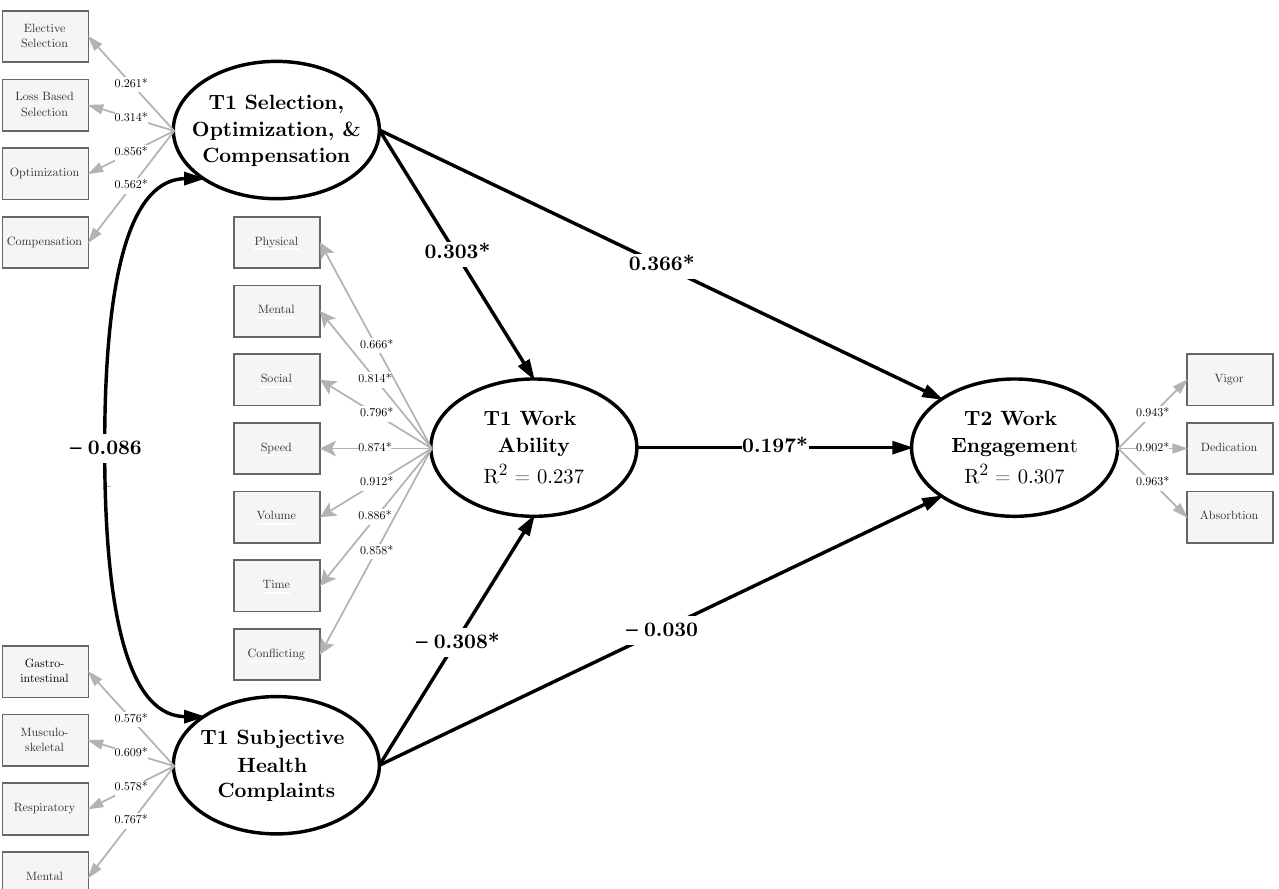
= 480.985, CFI = 0.948, ( 213 )